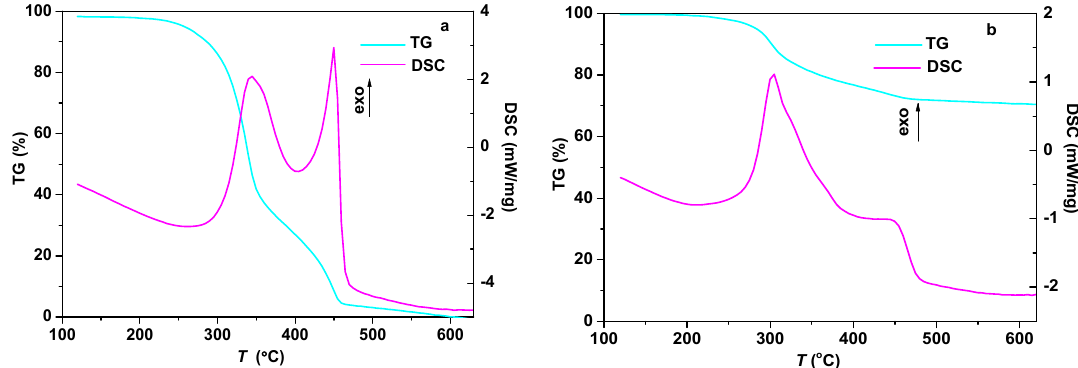
Figure 3. TG / DSC thermograms of the flax fiber before ( a ) and after ( b ) impregnation with a solution of titanium hydroxocomplexes.